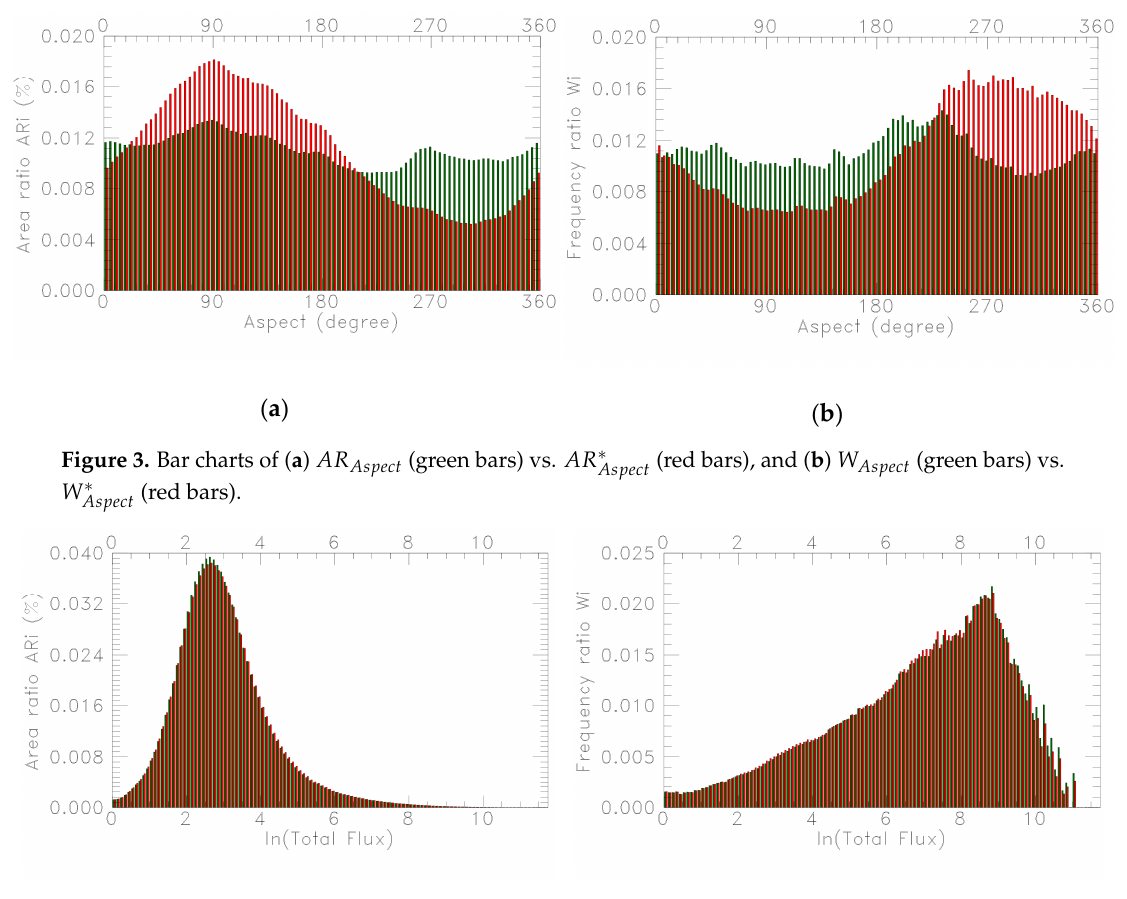
Figure 4. Bar charts of ( a )